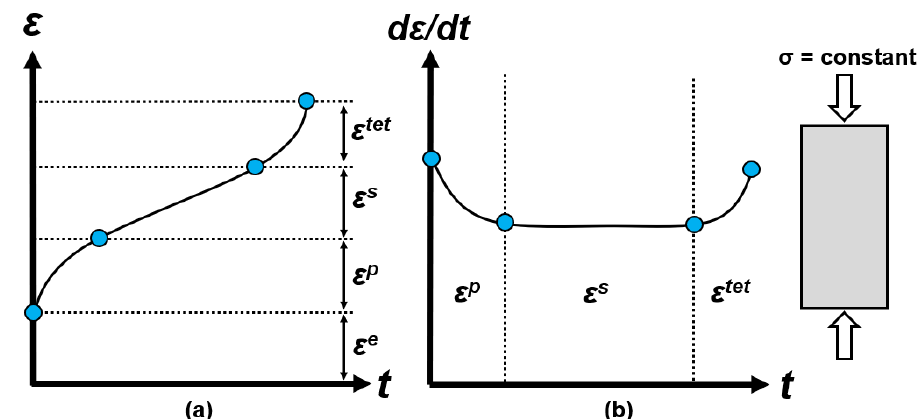
Figure 2. General creep curve in axial strain-time space for a specimen of rock under an applied constant load showing ( a ) the three stages of creep (primary, secondary, and tertiary) and ( b ) associated strain-rate time curve. The strain-rate curve is also referred to as the “bathtub” curve. Note that superscripts e, p, s , and tet denote elastic, primary, secondary, and tertiary, respectively.